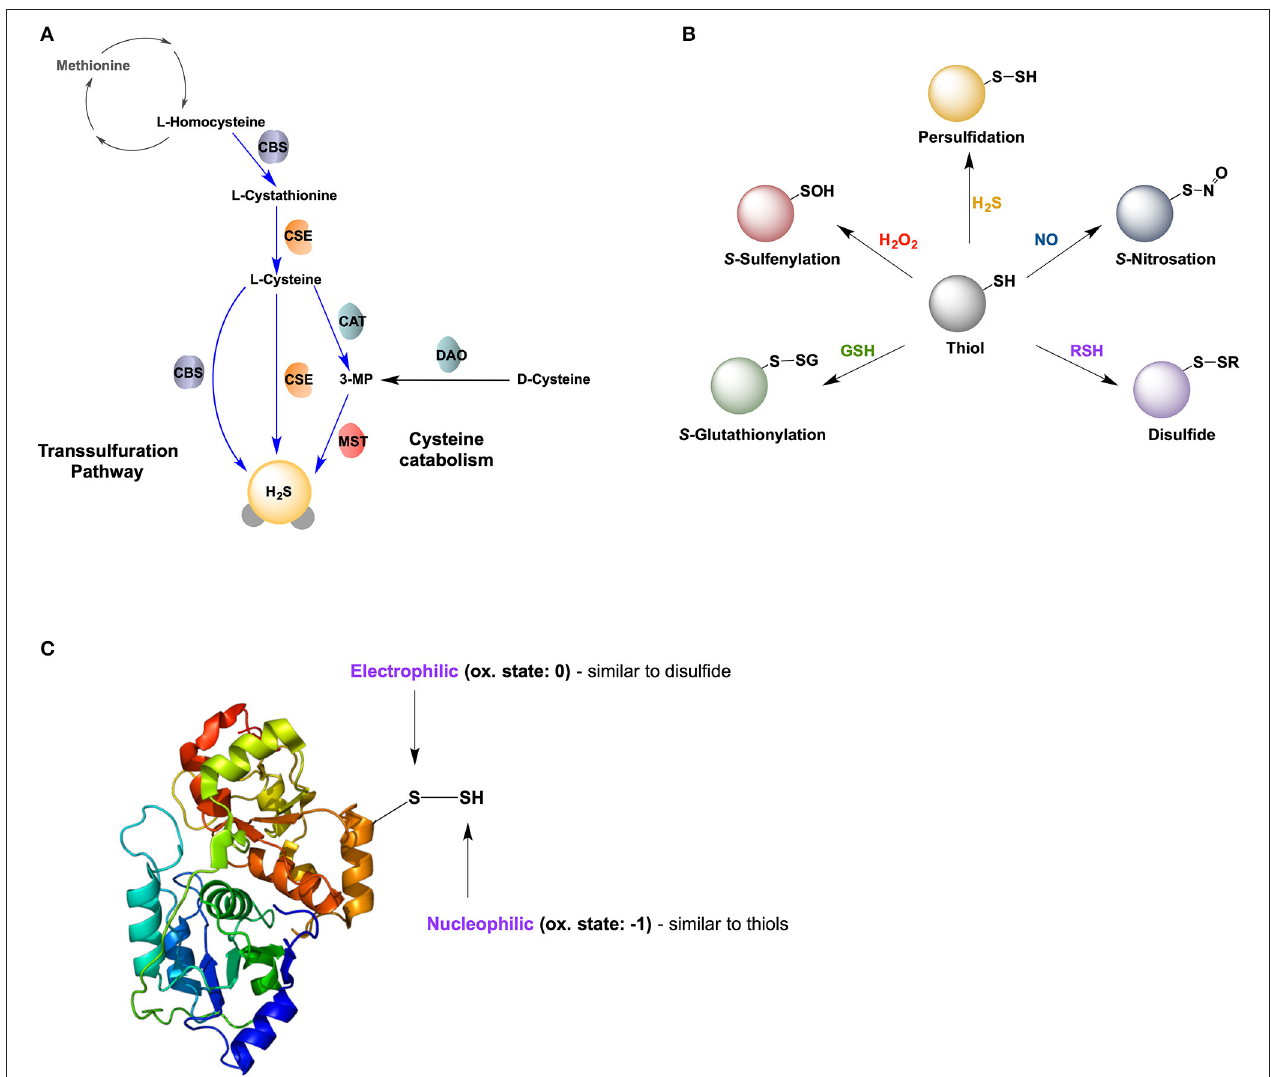
FIGURE 1 | Hydrogen sulfide and protein persulfidation. (A) Biosynthesis of H 2 S via transsulfuration pathway and cysteine catabolism. CBS: cystathionine beta synthase; CSE, cystathionine gamma lyase; CAT, cysteine aminotransferase; DAO, D-amino acid oxidase; MST, mercaptopyruvate sulfur transferase. (B) Reversible posttranslational modifications of cysteine. (C) Dual chemical nature of protein persulfides, with one sulfur atom being electrophilic and the other